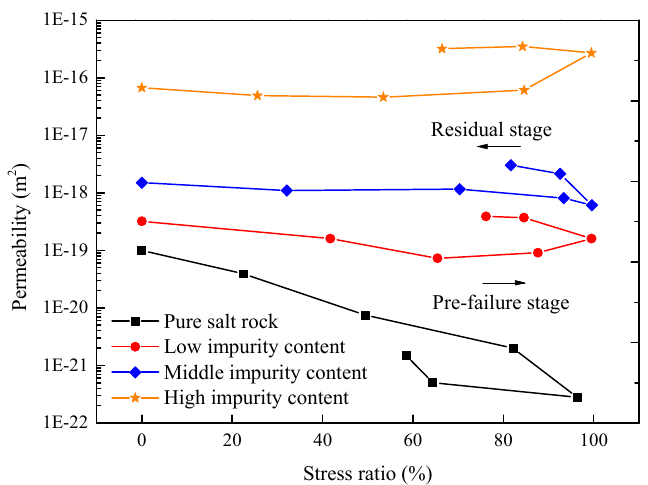
Figure 14. The permeability–stress ratio curves of the salt rocks with different impurity contents.